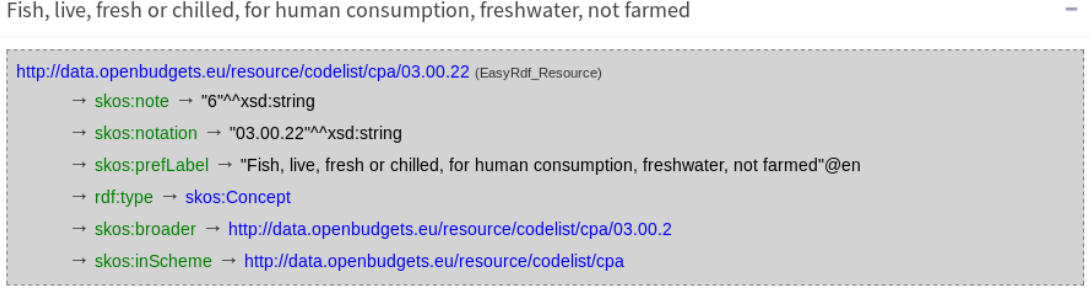
Figure 5. Detailed entity information.